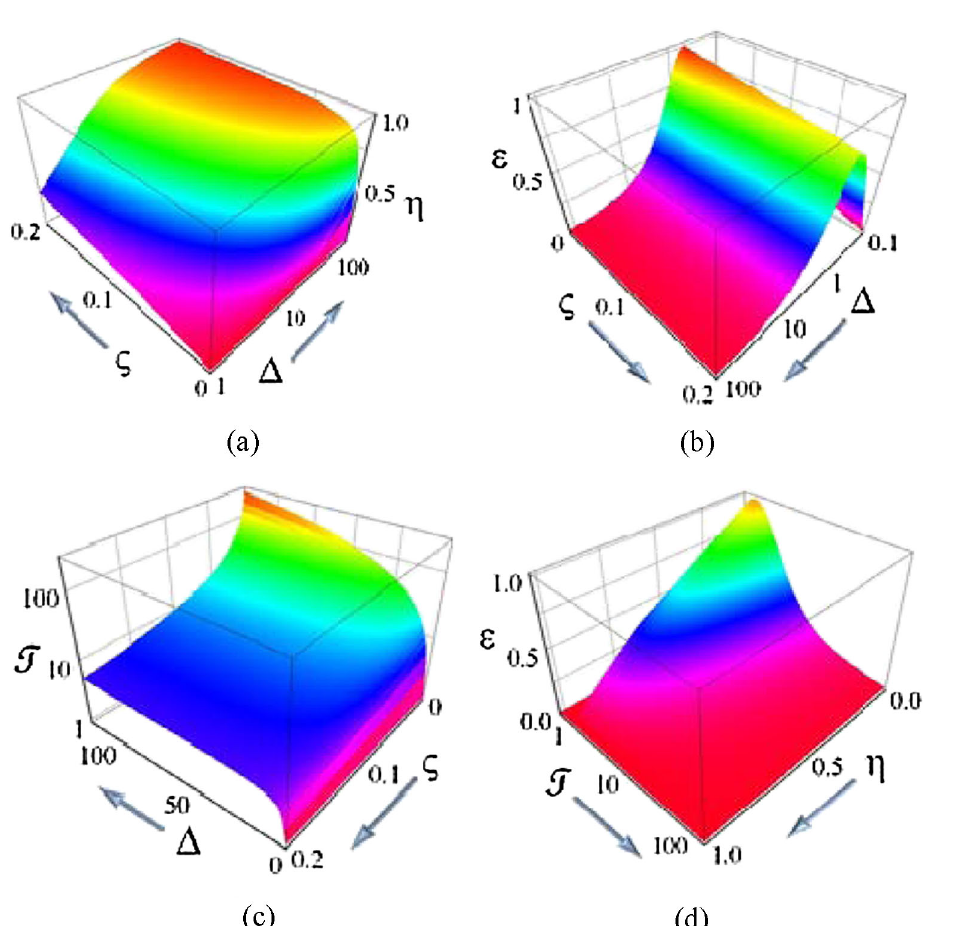
FIG. 10. (Color) Two-beam accelerator parameters. Parts (a), (b), and (c) show efficiency (cid:8) , normalized accelerating gradient seen by test particles " , and transformer ratio T , each as a function of modified current ratio & and normalized detuning (cid:3) . Part (d) shows " as a function of T and (cid:8)